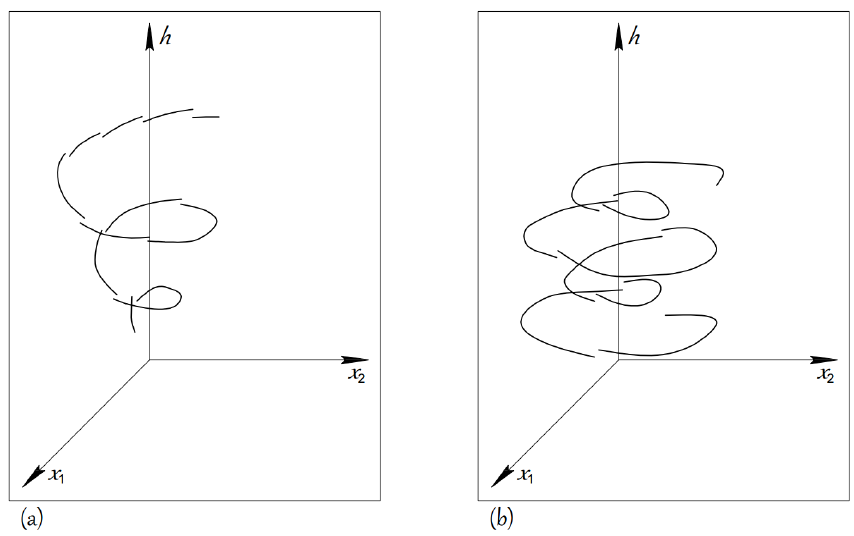
Figure 1. ( a ) The ( λ , A ) -globally practically exponentially stable behavior of Model (14), (15) with respect to the function h = with respect to the function h =